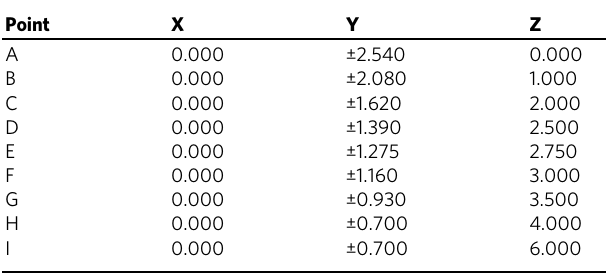
Table 2 Cartesian coordinates of H atoms for the points being studied in the Be + H 2 → BeH 2 reaction, in units of Bohr [ a ]